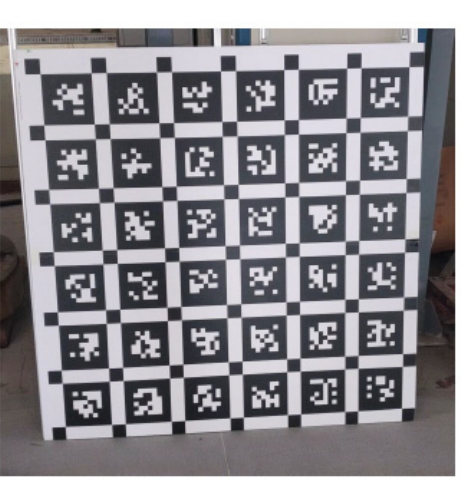
4. One Aruco calibration board, as shown in Figure 23.